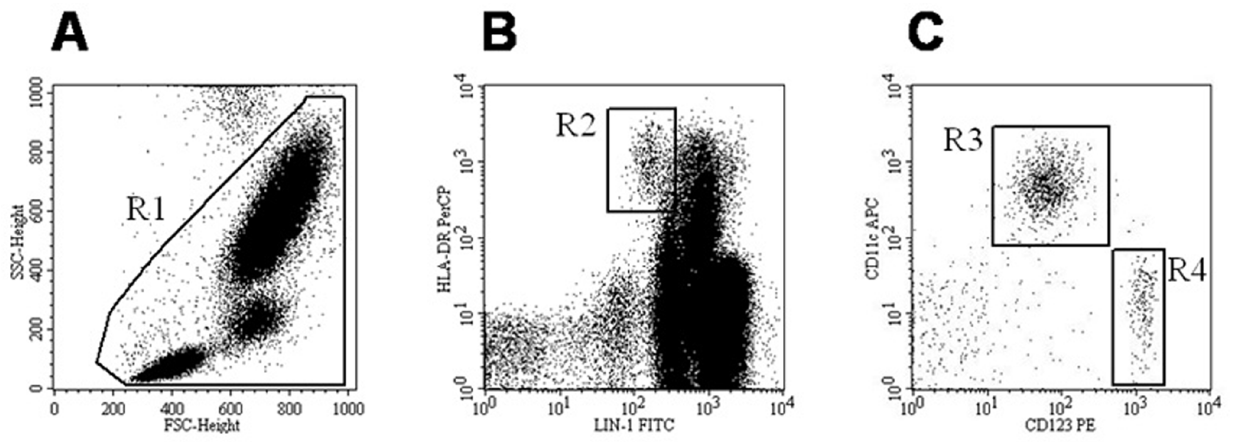
Figure 1. Gating strategy. Representative immunophenotype plots of the whole blood sample from one HC subject are reported to show the gating strategy. Total cells were identified in a forward scatter (FSC)/side scatter (SSC) plot and gated (R1, left panel A). Then DC were identified by gating lineage negative (Lin 2 ) cells (R2, middle panel B). Finally, myeloid DC (R3) were identified by CD11c and HLA-DR expression, while plasmacytoid DC (R4) were identified by CD123 and HLA-DR expression (right panel C).